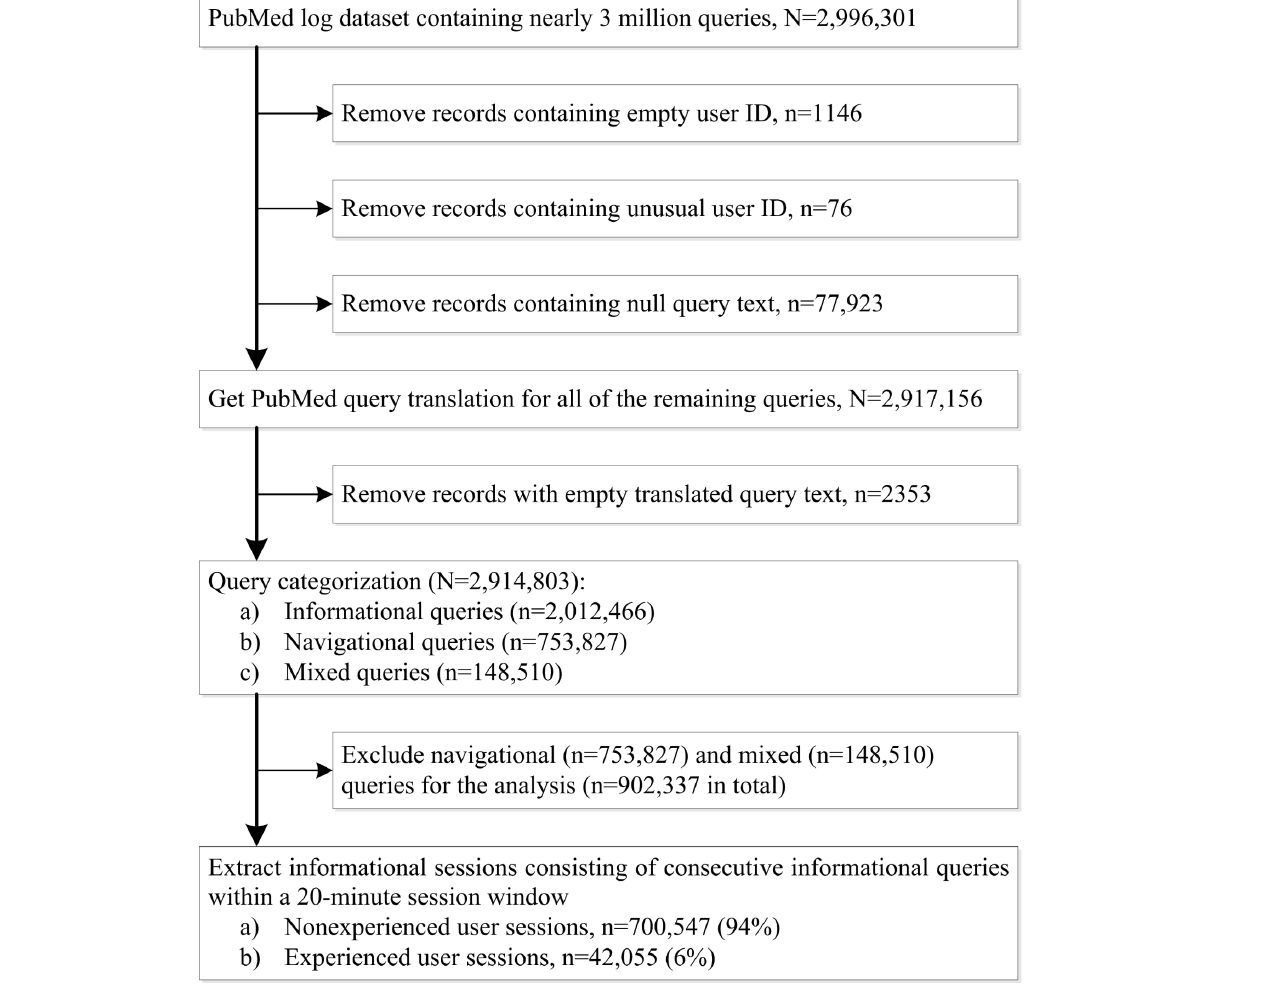
Figure 1. Data cleaning and